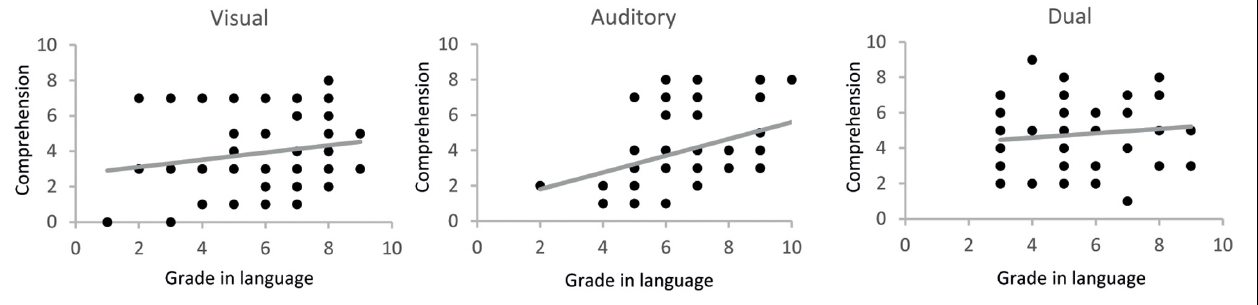
FIGURE 2 | Correlations between grades in language and verbal comprehension for different presentation modalities. Graphs show individual data for text comprehension and grades in Spanish native language. Every dot corresponds to a student with available grades ( n = 64.53, 59, for visual, auditory, and dual groups). Some dots ovelap. Dotted lines are regression lines fitted to the experimental data with correlation coefficients and p -values, respectively, for each group: visual, r = 0.163, p = 0.19; auditive, r = 0.382, p = 0.004; dual, r = 0.101, p =